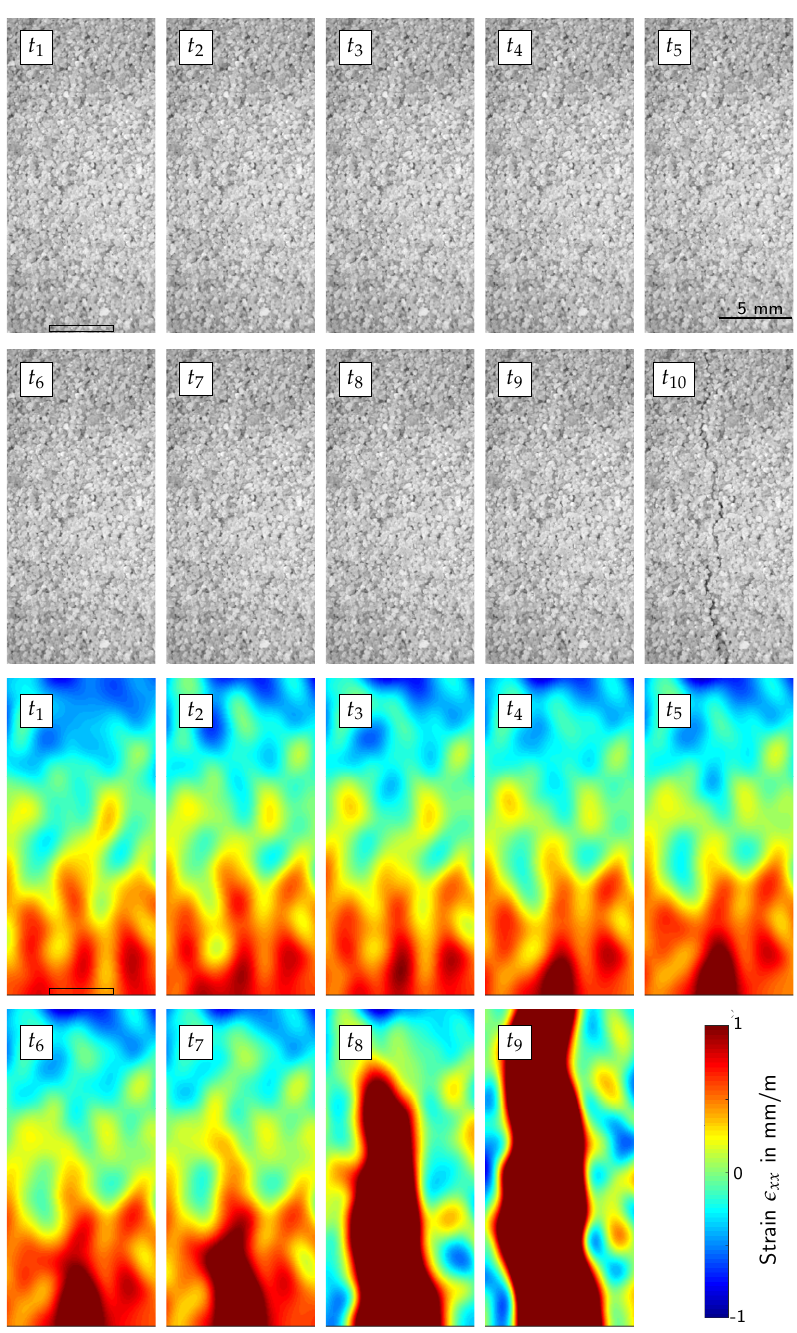
Figure 8. Strain calculation via digital image correlation for a 3-point-bending (3PB) experiment and 10 points in time ( t 1 – t 10 ). Only the area under the punch is analysed. Starting at t 2 , the strain starts to localise until the fracture is complete at t 9 , which is still undetectable by the human eye. We added a scale to the